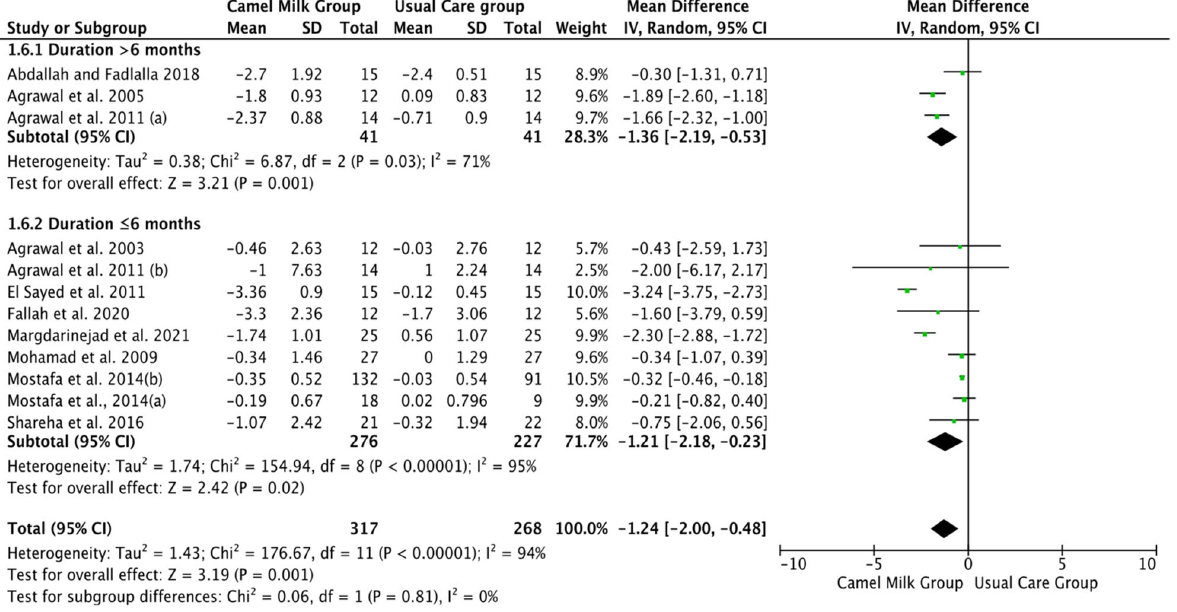
Figure 15. Forest plot for the effect of CM intake on HbA1c levels based on the intervention duration. Note: Mostafa and Al ‐ Musa, 2014 (a) for T1DM and (b) for T2DM.